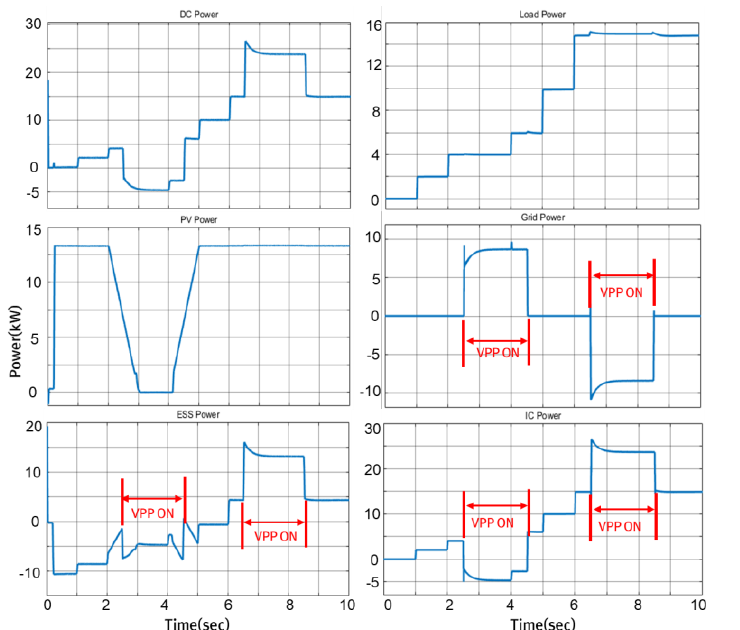
Figure 11. Comparison among